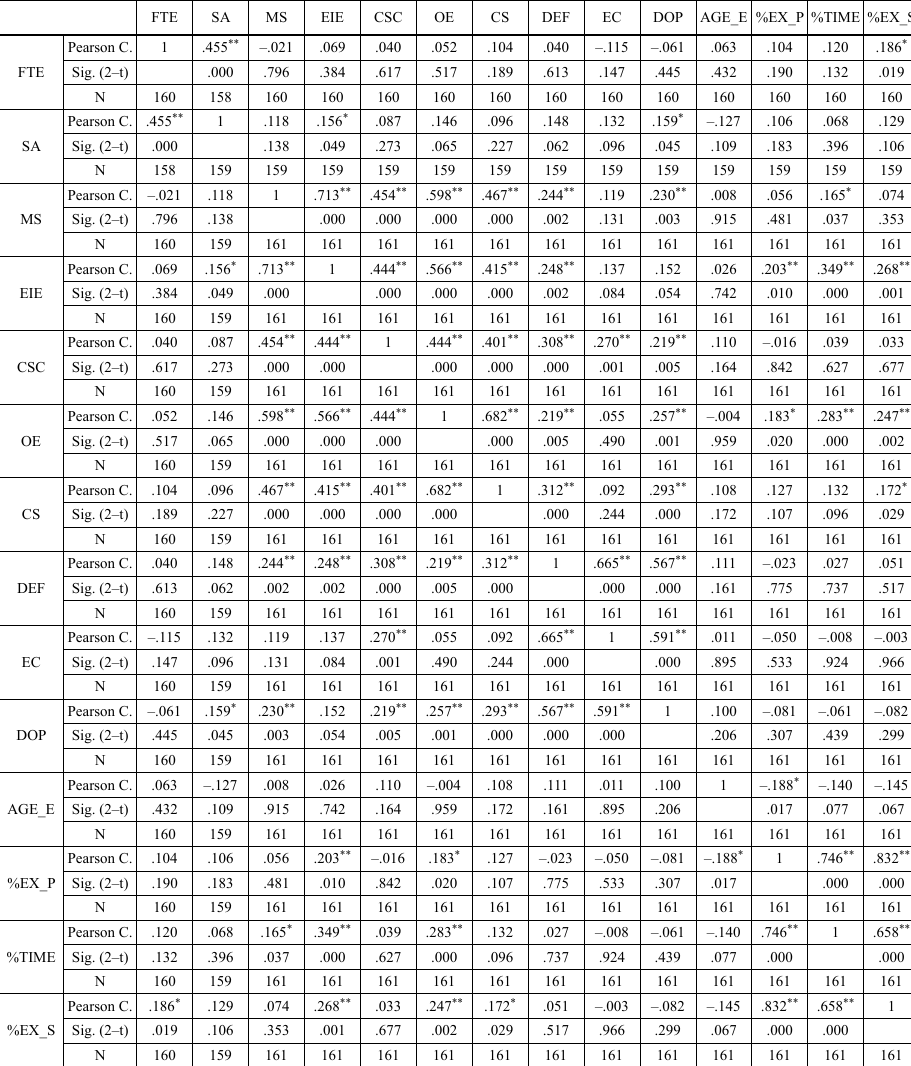
Table 5. Correlation matrix for all variables used in the